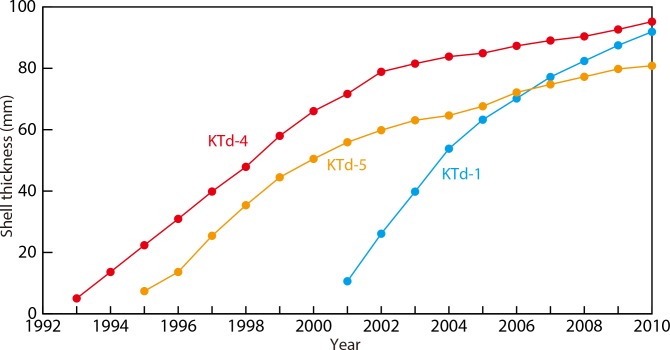
Annual rate of shell thickening of Tridacna derasa estimated from seasonal variations in δ18Oshell values.Each annual increment represents a distance between annual δ18Oshell maxima, which was measured perpendicular to growth lines/bands.